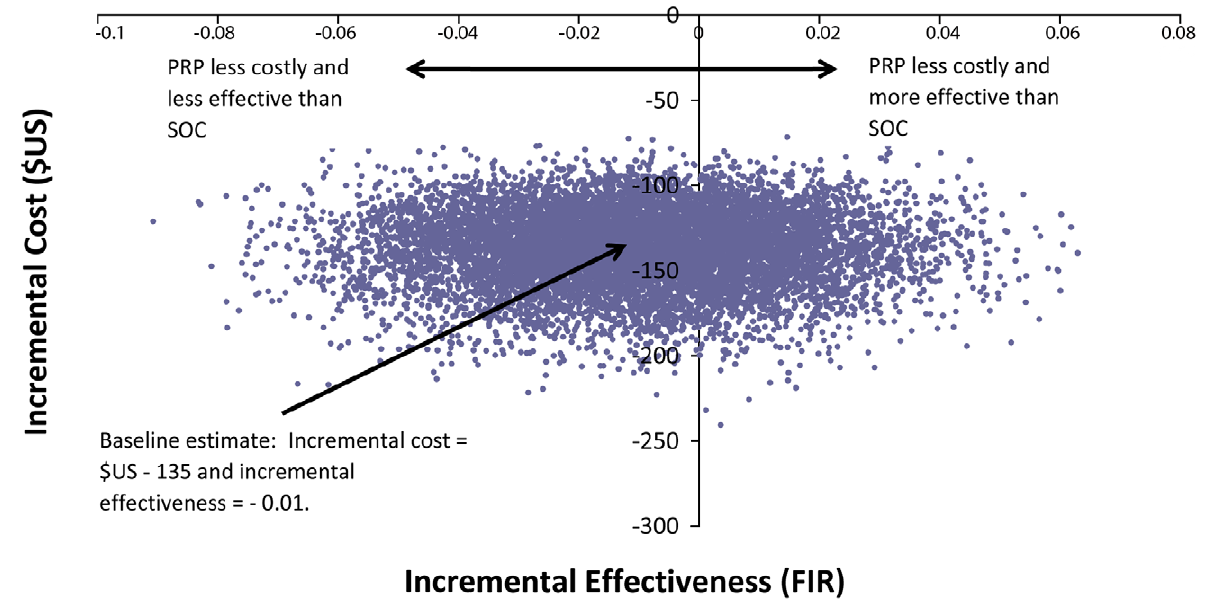
Figure 2. Scatter plot of estimated joint density of incremental costs and incremental effects of Pharmacy-only Refill Program (PRP) versus Standard of Care (SOC) by Monte Carlo simulation.